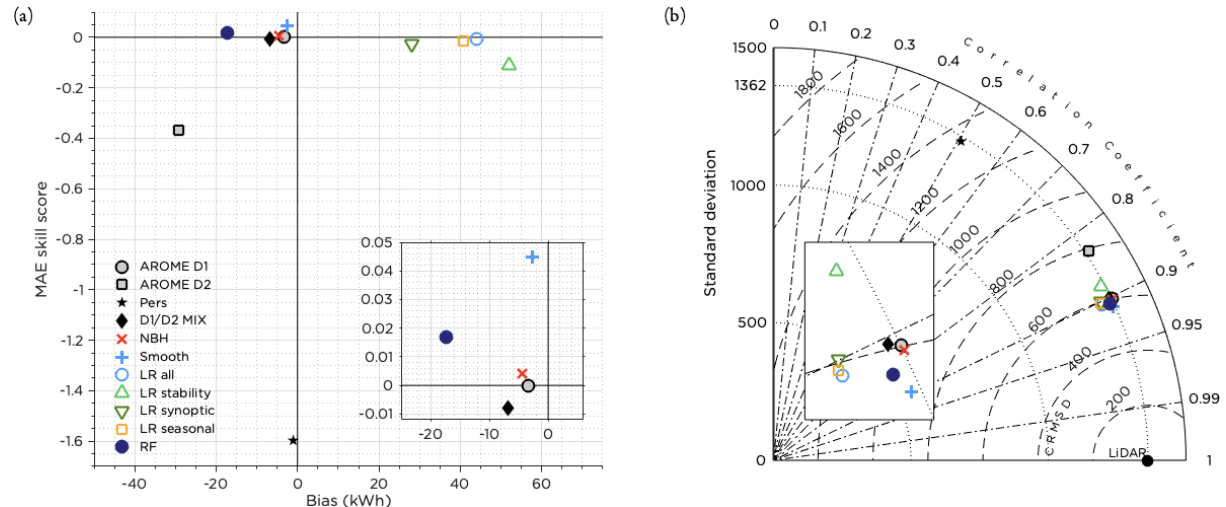
Figure 7. Performance of all post-processing methods during the test period. Panel (a) shows the MAE skill score and bias and panel (b) the Taylor diagram. The insets in panels (a) and (b) show enlarged portions of the figures to more clearly show the differences between the